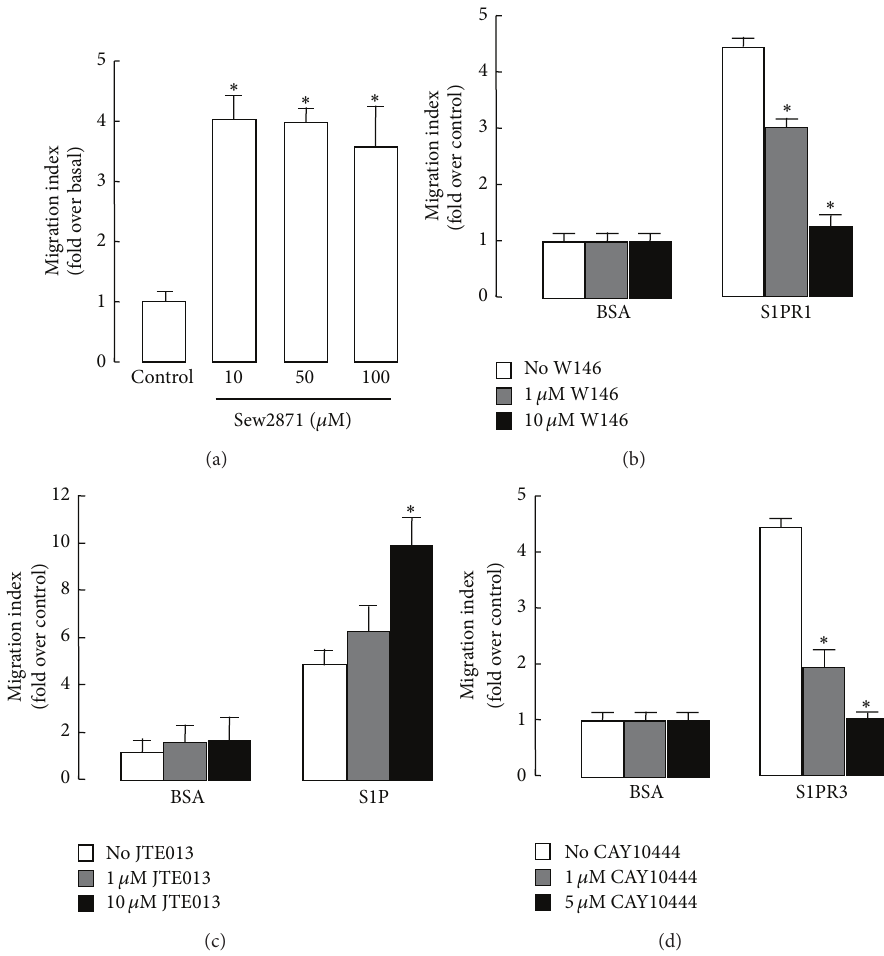
Figure 4: The effect of S1PRs agonist or antagonist on S1P-induced human BMSCs migration. (a) Serum-starved cells were allowed to migrate for 4h in the presence of the indicated concentration of SEW2871, an S1PR1 agonist. (b)–(d) Serum-starved cells were pretreated for 1h with or without the S1PR1 antagonist W146 (b), S1PR2 antagonist JTE-013 (c), and S1PR3 antagonist CAY10444 (d). Pretreated cells were then allowed to migrate in the presence of S1P. Data are presented as the mean ± SD. ∗ 𝑃 < 0.05 , compared with